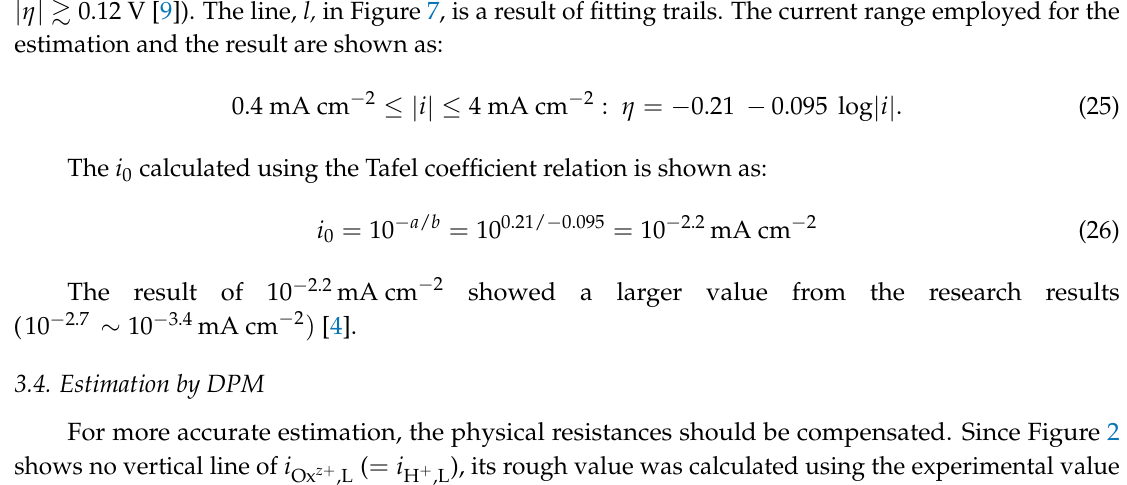
Figure 7. The extract E exp ( i ) from Figure 1 is shown. The tacit Tafel extrapolation method (TEM) may be applied in the green area ( E ( i ) (cid:46) − 0.14 V vs. SHE ) ∩ (cid:4666)0.4 mA cm (cid:2879)(cid:2870) (cid:3409) |(cid:1861)|(cid:4667) . The (B) and (C) correspond to that in Figure 1.